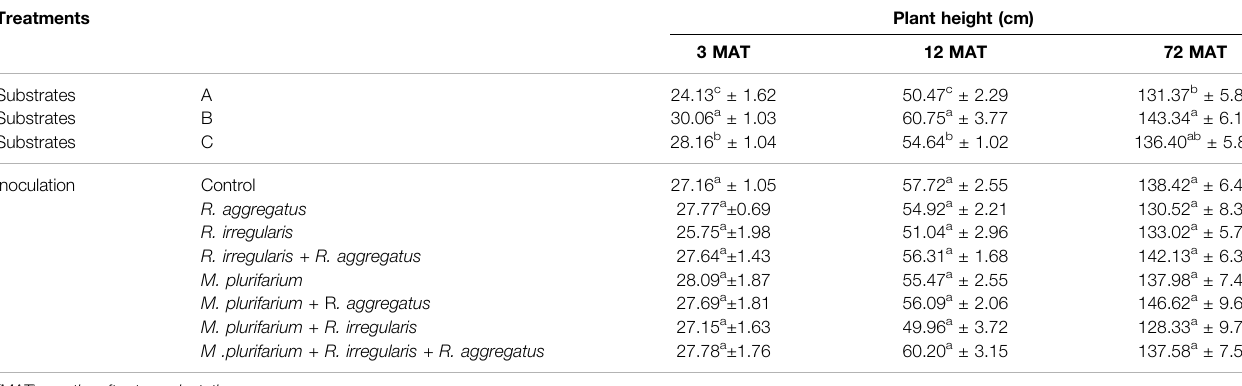
TABLE 5| Growth (height)of S.senegal seedlings thatweregrown ondifferentinoculatedoruninoculatedsubstratesin fi eldminefrom 3to72MAT.Foreach factor, means of values followed by the same letter in the same column do not signi fi cantly differ according to the Bonferroni step-down test at p < 0.05. Means ± standard errors are shown (n = 8).